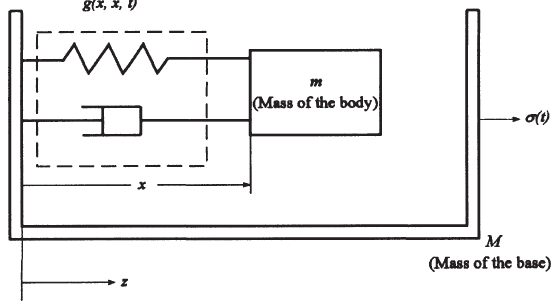
Fig. 1. The base and the body to be